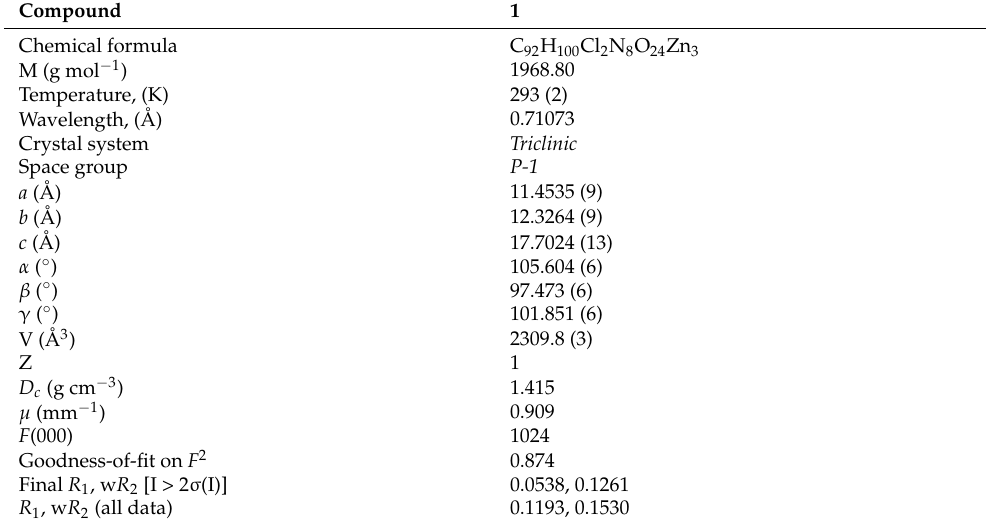
Table 1. Crystallographic data, details of data collection, and structure refinement parameters for compound 1